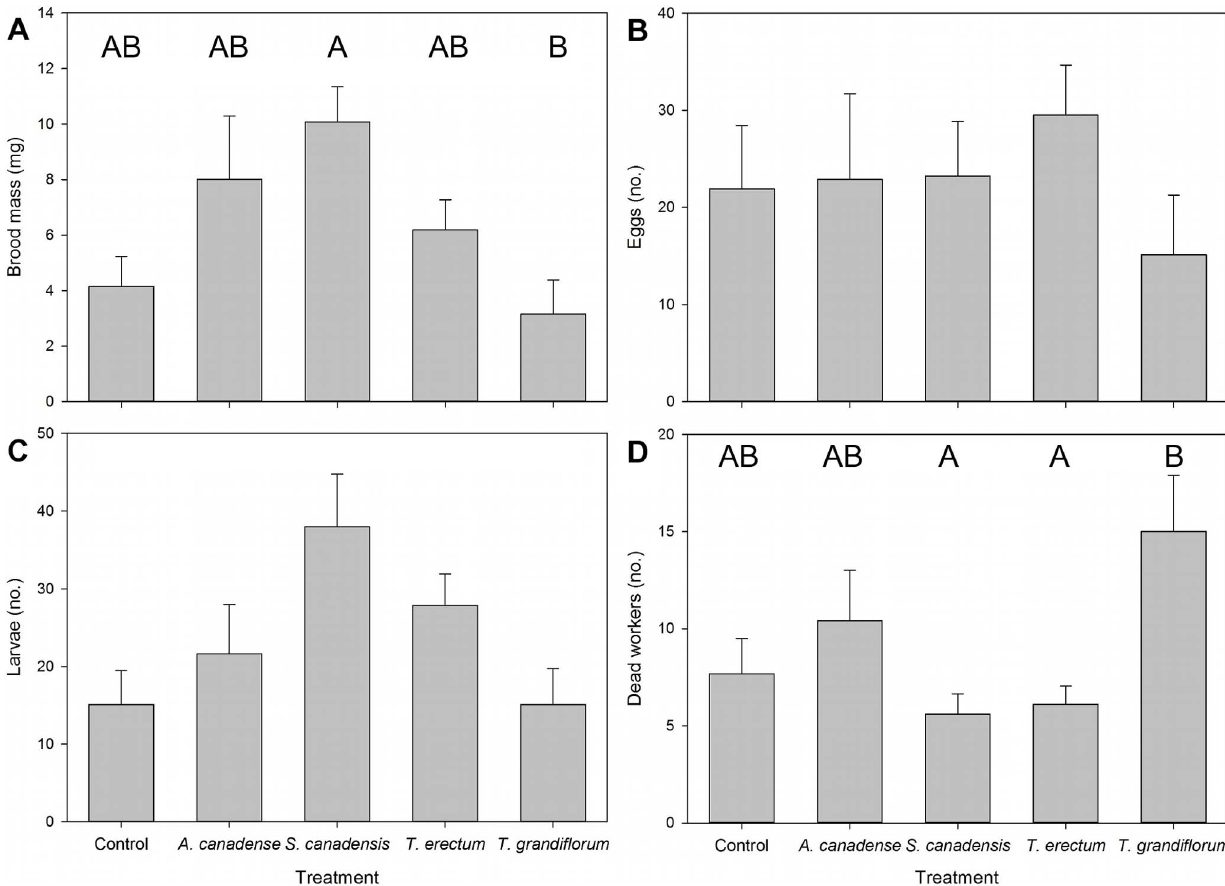
Figure 4. Effects of diet treatment on colony performance. Mean ( 6 SE) a) brood mass and b) numbers of eggs, c) larvae, and d) dead workers 10 weeks after treatment. Different letters indicate statistically significant differences (Tukey-adjusted p # 0.05).